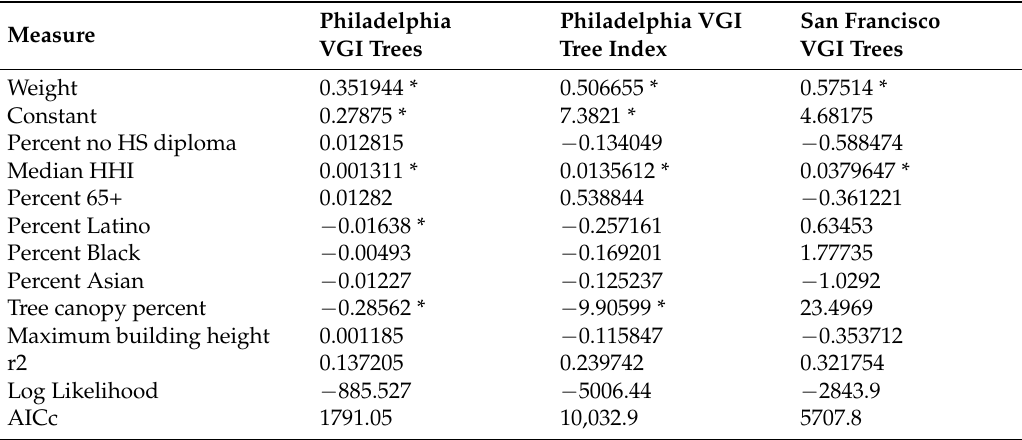
Table 5. Spatial autoregressive